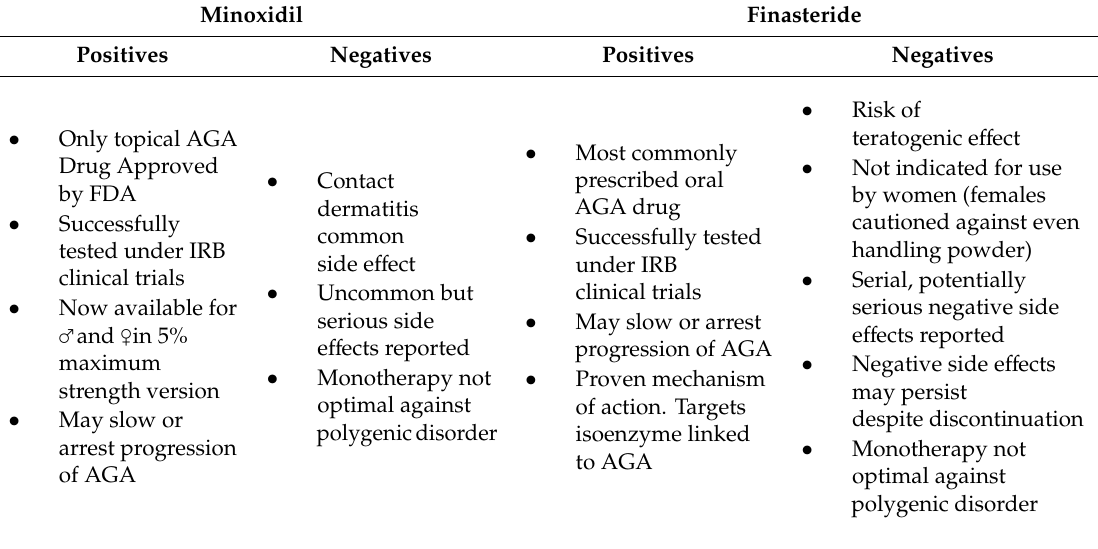
Table 1. Drug-based therapy, benefits vs.